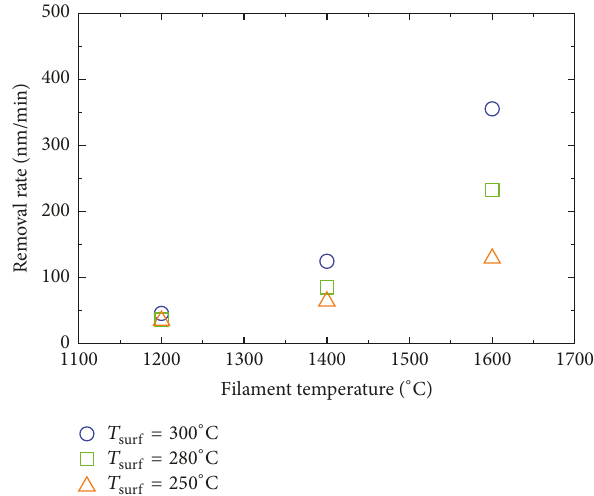
Figure 4: The removal rate as a function of the filament temperature when the surface temperatures were 250, 280, and 300 ∘ C, respec- tively.